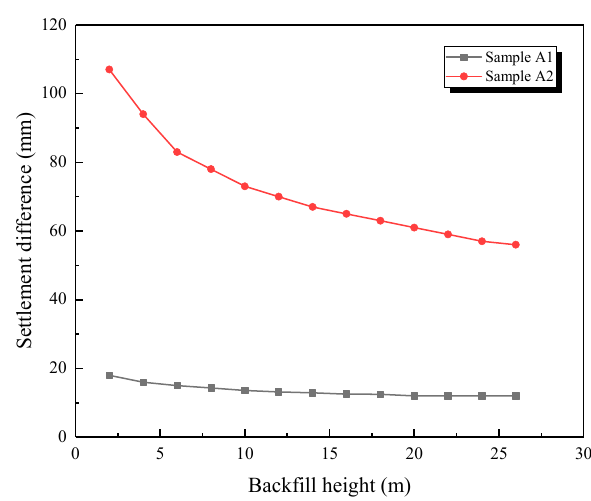
Figure 21. Settlement difference variation law as the backfill height increased.